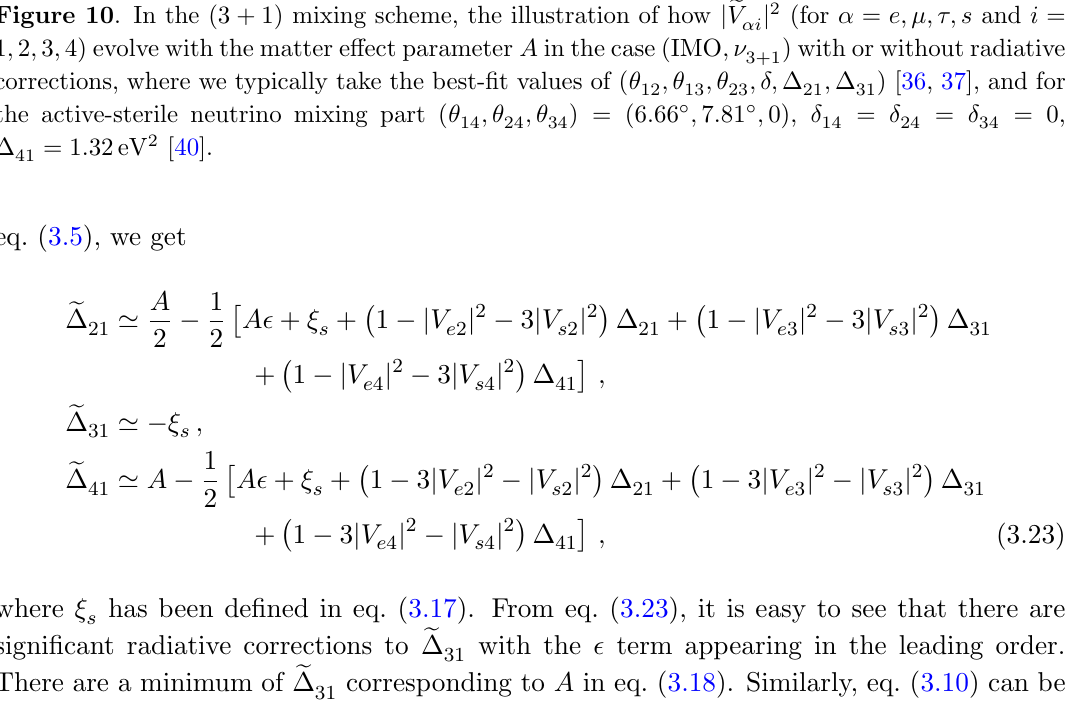
Figure 10 . In the (3 + 1) mixing scheme, the illustration of how 1 ; 2 ; 3 ; 4) evolve with the matter e(cid:11)ect parameter A in the case (IMO ; (cid:23)